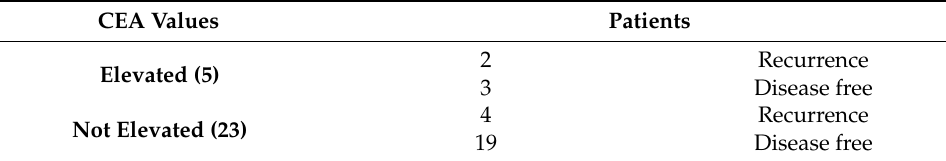
Table 3. CEA values with tumor recurrences.